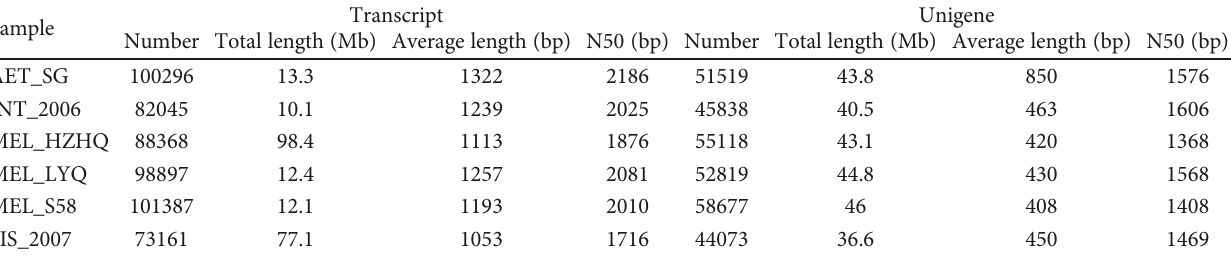
Table 2: Summary feature of the eggplant transcriptome assemblies.